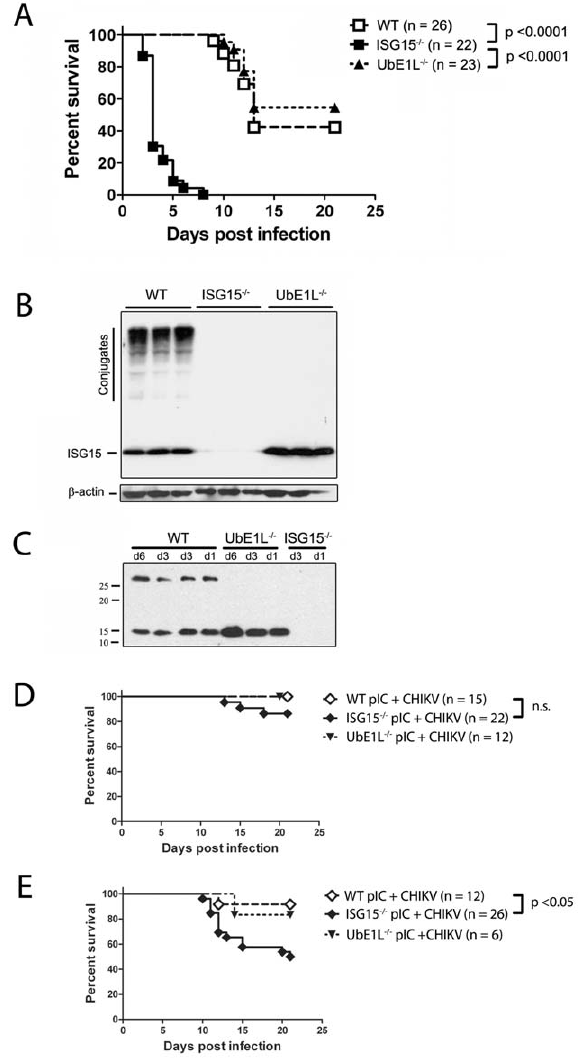
Figure 6. ISG15, independent of UbE1L, plays a critical role during the neonatal response to CHIKV. ( A–C ) WT, UbE1L 2 / 2 and ISG15 2 / 2 mice were infected with 2 6 10 5 PFU CHIKV s.c. at nine days of age. (A) Mice were monitored for lethality for 21 days with data displayed as Kaplan-Meier curves. (B) Skin and muscle homogenates from the site of infection were collected on day 2 post infection and analyzed for ISG15 expression by western blot. (C) Sera collected on days 1, 3 and 6 post- infection and analyzed as in (B). ( D and E ) ISG15 2 / 2 , UbE1L 2 / 2 and WT mice (8 days of age) were injected i.p. with (D) 25 m g or (E) 10 m g of pIC and 24 hours later mice were infected s.c. with